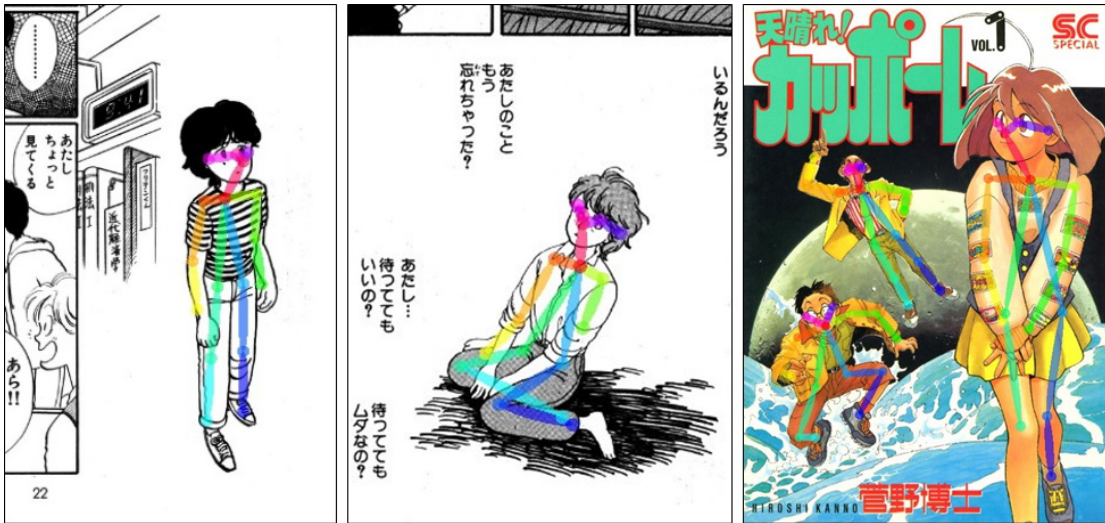
Figure 5. Some examples of Open Pose application on comic pages [27]. This model works well for comics as long as the drawings are realistic, so it fails in most cases. Source: images extracted from the Manga109 dataset [10], c (cid:13) Yoshi Masako, c (cid:13) Kanno